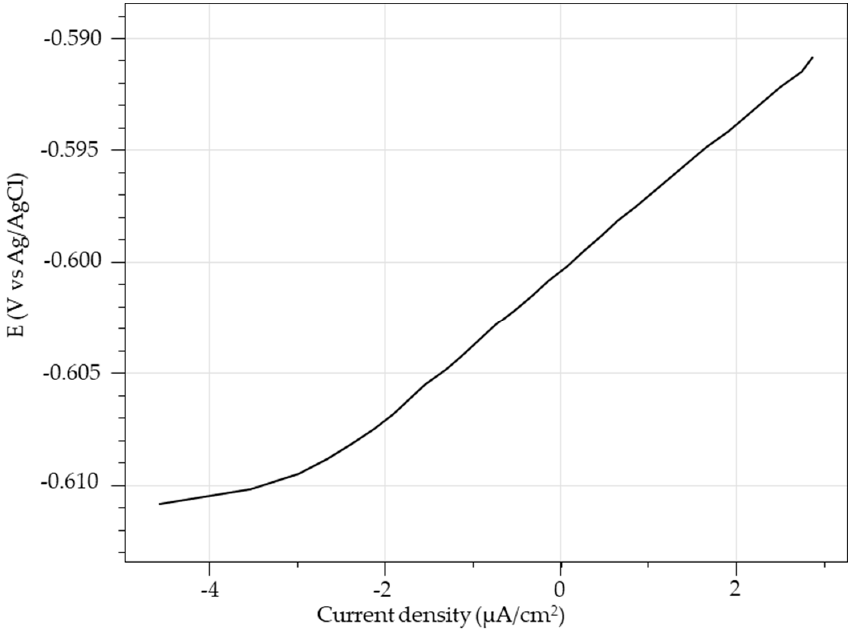
Figure 4. A typical linear polarization curve for a sample (S5) in seawater (SW), exposed for 14 days.